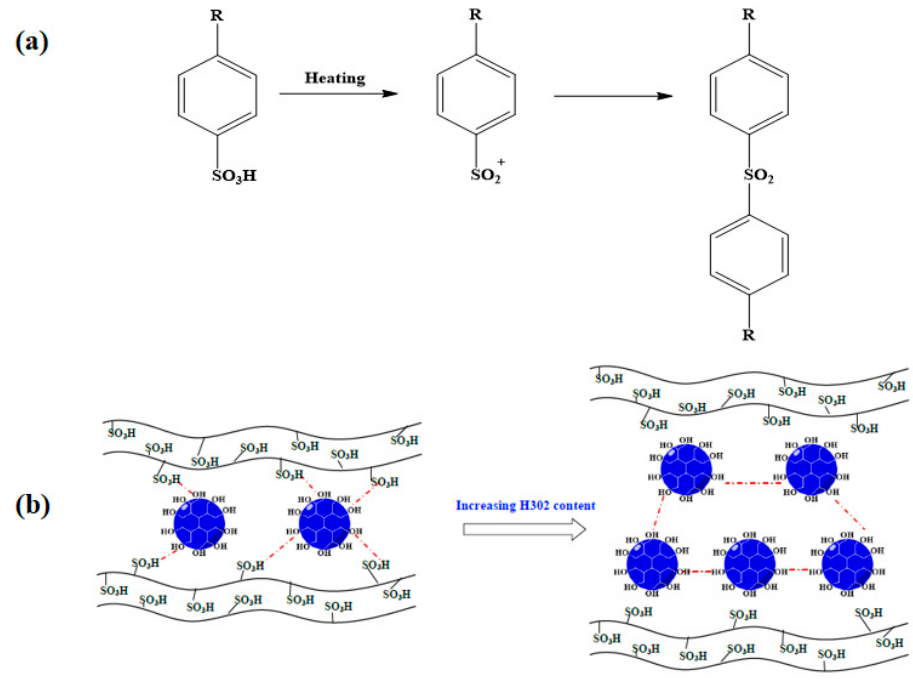
Figure 8. Schematic diagram of ( a ) thermal-crosslinking of S-SEBS without crosslinker and ( b ) H-bonding interaction between H302 in thermal-crosslinking with S-SEBS.